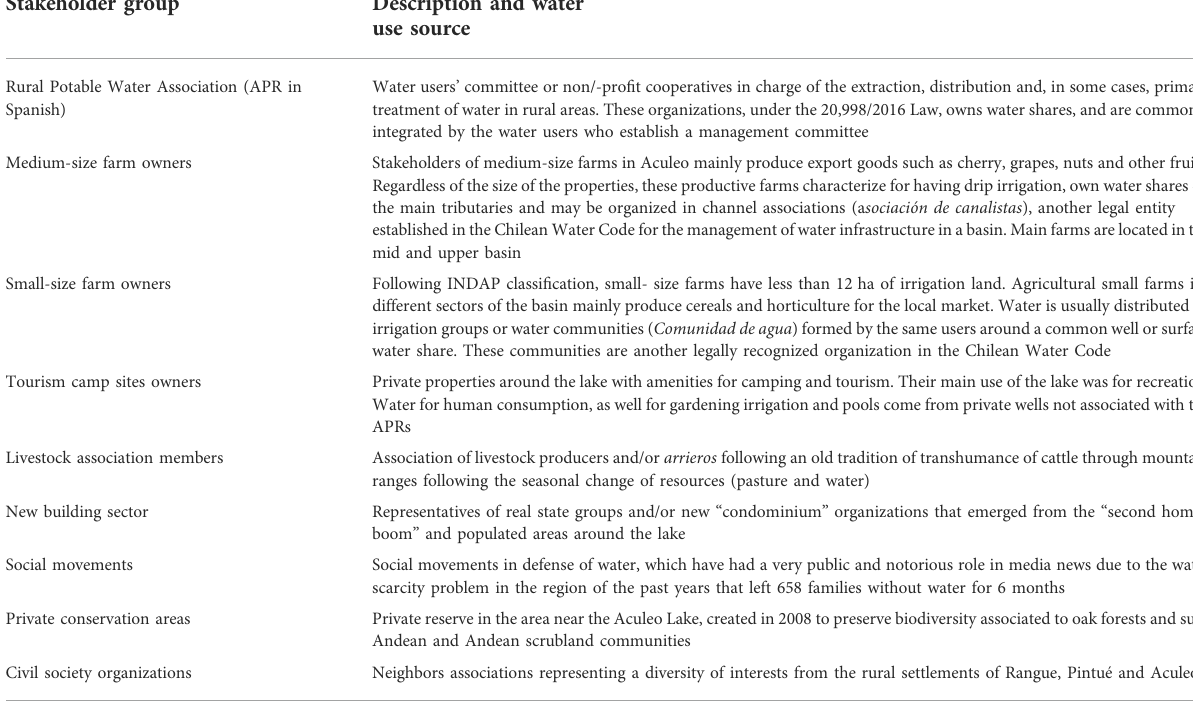
TABLE 1 Groups of stakeholder groups interviewed in the Aculeo Lake